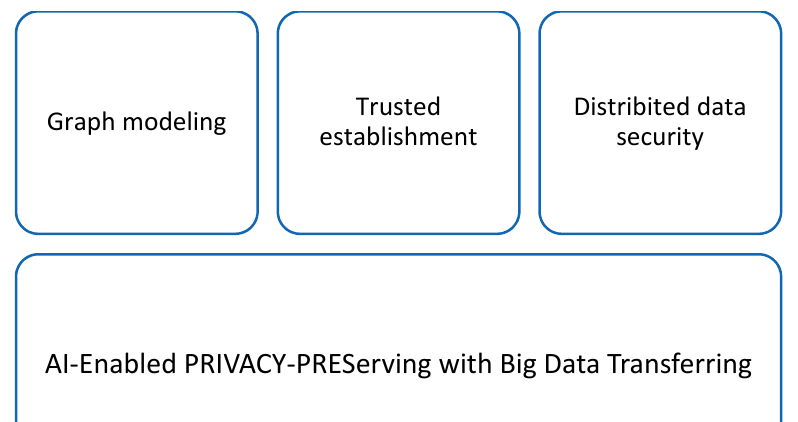
Figure 1. Components of the proposed algorithm.